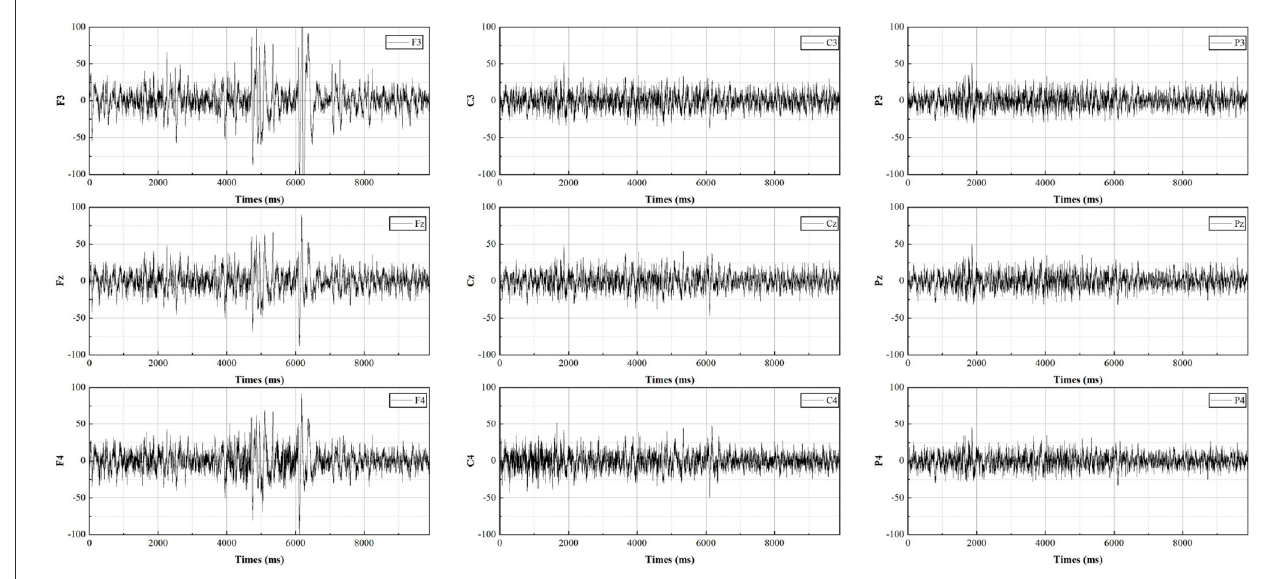
FIGURE6 The average potential value for females during vertical swiping.